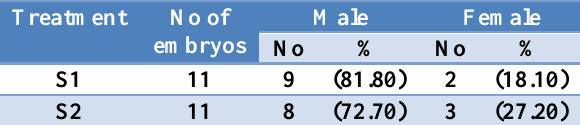
Table, 2:- Percentage of male and female embryos obtained after swim-up compared with the expected percentage of 50% of each gender and between treatments . Treatment